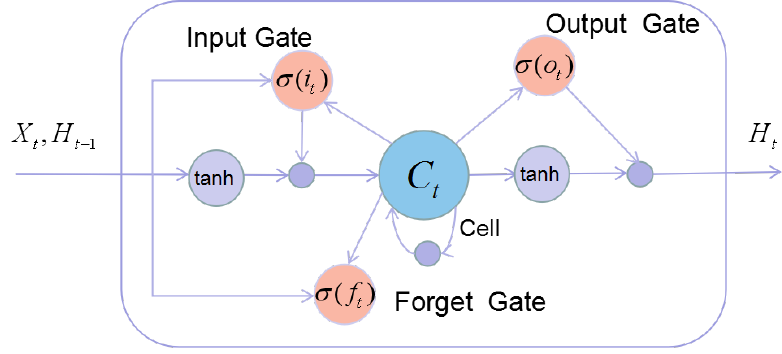
Figure 3. The structure of